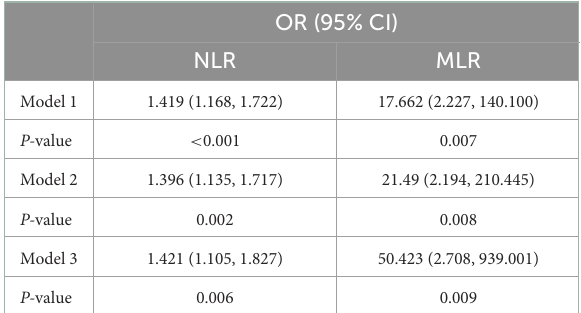
TABLE 3 Relationship between NLR and MLR and clinical outcome in patients with VE in different